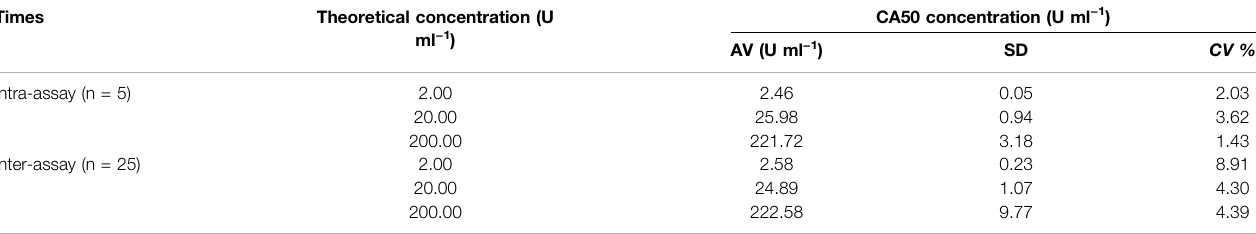
TABLE 1 | Intra-assay and inter-assay tests of the fully automated miniaturized analyzer.